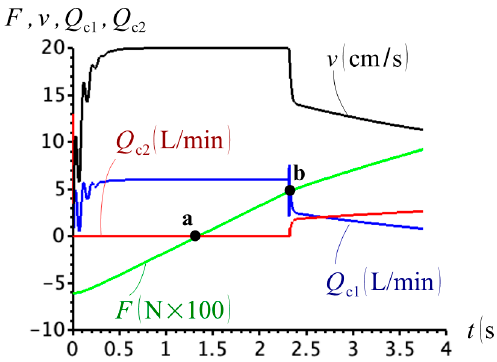
Figure 9. External force, cylinder velocity and check valve flows for m = 250 kg and p c = 20 bar .